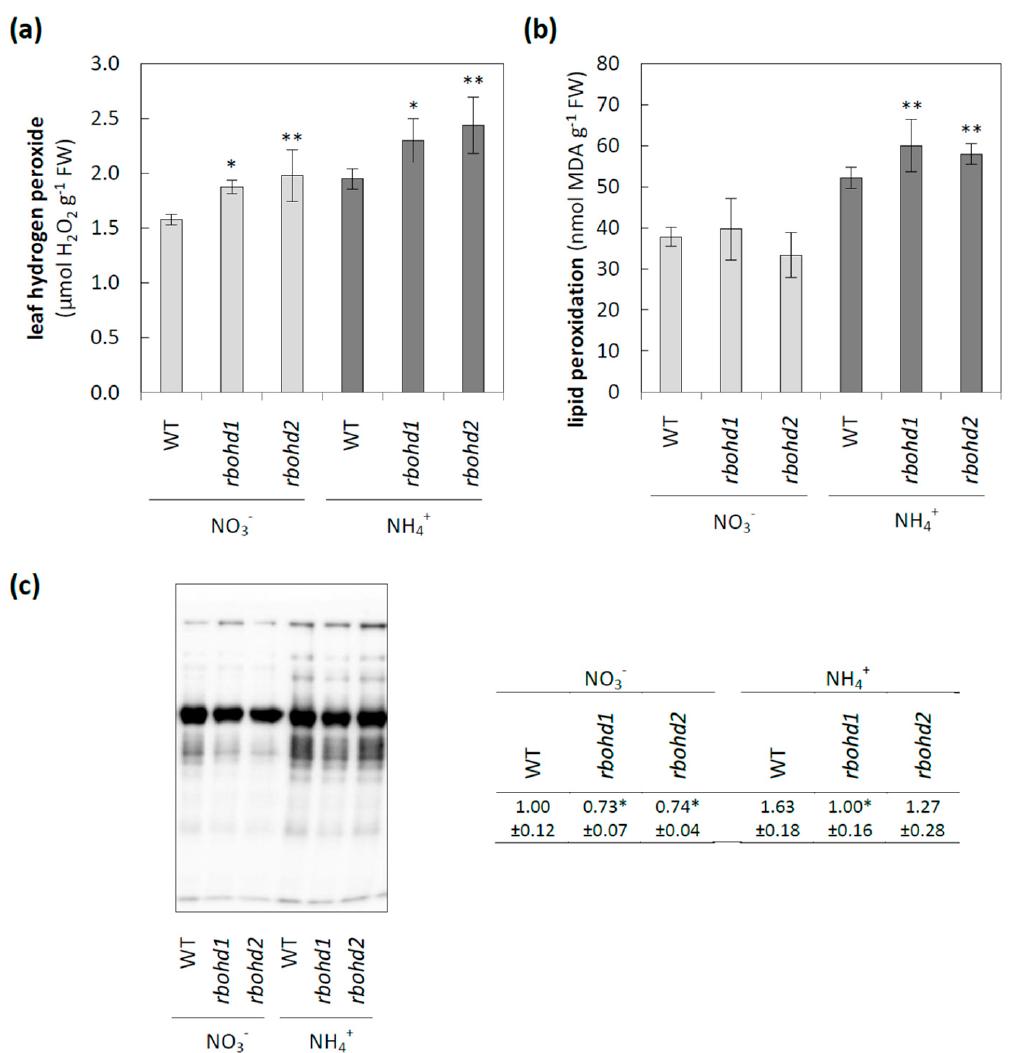
Figure 2. ROS level and biomolecule injuries in leaf tissue of WT and rbohd plants grown in nitrate or ammonium as a nitrogen source. ( a ) Leaf hydrogen peroxide concentration. ( b ) Membrane injury is measured as malondialdehyde content. ( c ) The profile of protein carbonylation in leaf tissues. Comparison tests between rbohd and WT plants were performed on the mean experimental conditions for the nitrate (light grey) or ammonium (dark grey) growth regime separately. Statistical differences calculated using one-way analysis of variance (ANOVA) with Tukey’s post hoc test are indicated at p -value ≤ 0.01 ** and p -value ≤ 0.05 *.